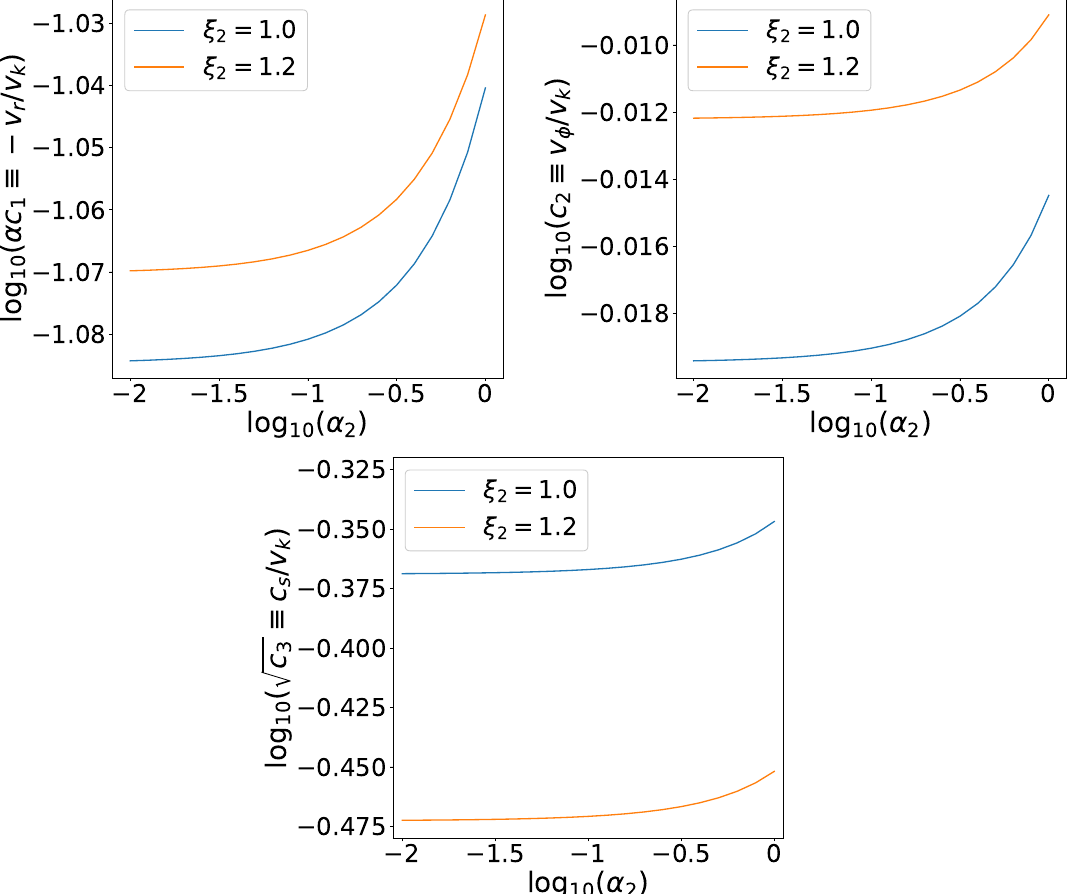
Figure 2. The properties of the accretion flow when outflow is present ( s = 1/2). The top-left panel plots radial infall velocity (in units of Keplerian velocity) as a function of the strength of anisotropic pressure ( α 2 ). The top-right panel plots rotational velocity (in units of Keplerian velocity) as a function of the strength of anisotropic pressure ( α 2 ). The lower panel plots sound speed (in units of Keplerian velocity) as a function of the strength of anisotropic pressure ( α 2 ). The viscous coefficient α 1 was set to be 0.1. The ratio of magnetic to gas pressure β was set to be 0.1. ξ 1 is the ratio of outflow radial velocity to inflow radial velocity. ξ 2 is the ratio of outflow rotational velocity to inflow rotational velocity. ξ 3 is the ratio of outflow sound speed to inflow sound speed. We set ξ 1 = ξ 3 = 1. The blue and yellow lines correspond to ξ 2 = 1 and ξ 2 = 1.2,